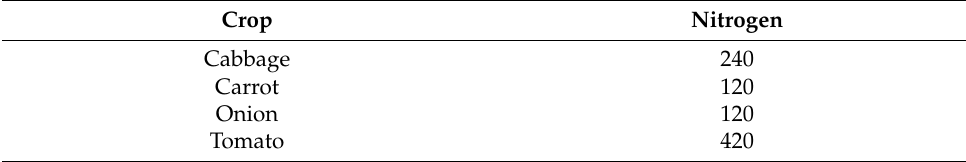
Table 2. Maximum annual nitrogen rate per hectare in fertilizer equivalent (in